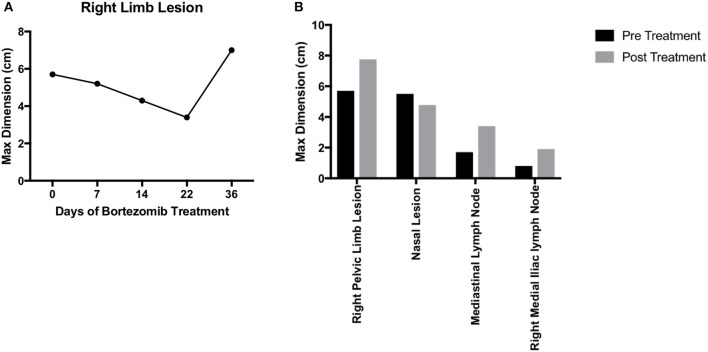
Translation of bortezomib into clinic. (A) At the time of metastatic spread of disease, the patient had lesions in the mediastinal and right iliac lymph nodes, the nasal mucosa, and local recurrence at the right pelvic limb. The patient was started on systemic bortezomib therapy at a dose of 1.3 mg/m2 twice weekly and palliative radiation therapy of 8 Gy by four fractions, once weekly, for pain from the right pelvic limb lesion. Measurement of the pelvic limb lesion during therapy showed decrease in maximal tumor dimension throughout 3 weeks of radiation therapy and systemic bortezomib; though, there was an increase in size 2 weeks after both therapies were stopped. (B) CT staging studies and physical exam demonstrated an interval increase in tumor size at all sites of disease and after discontinuation of bortezomib therapy. The canine patient was then transitioned to palliative care.